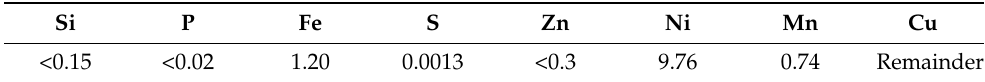
Table 1. Chemical composition (wt%) of B10 copper alloy. Si P Fe S Zn Ni Mn Cu <0.15 <0.02 1.20 0.0013 <0.3 9.76 0.74